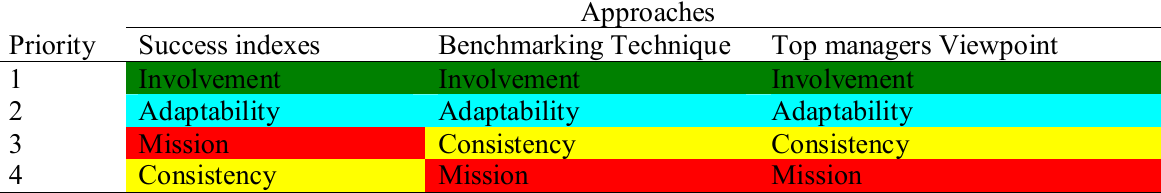
Comparing 3 approaches result Priority Success indexes Benchmarking Technique Top managers